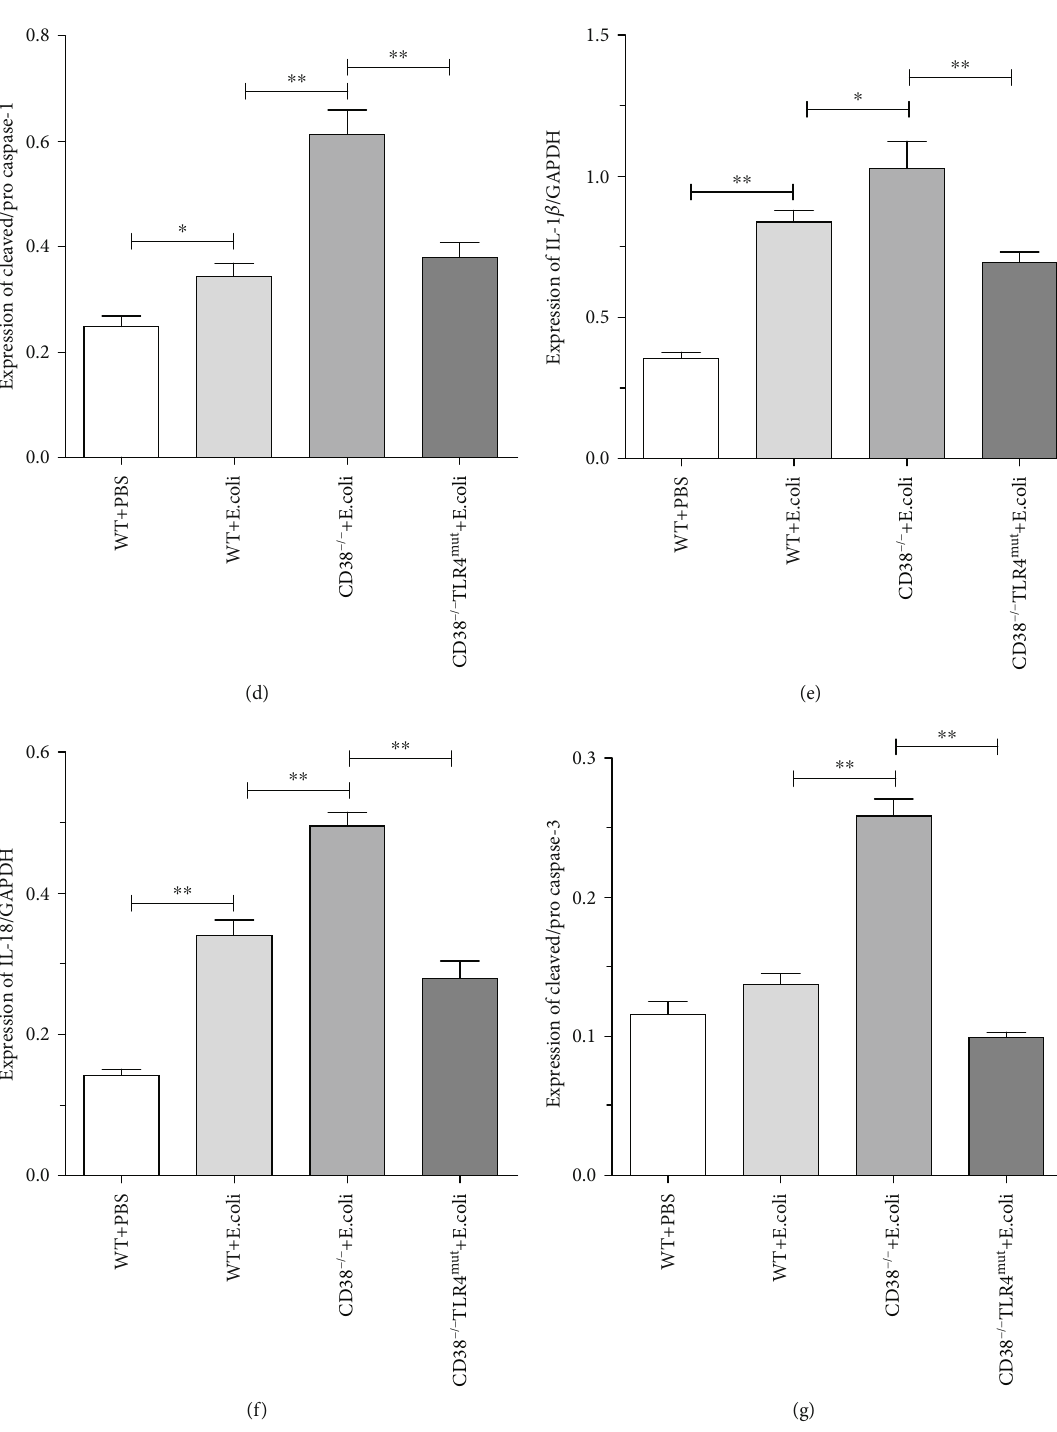
Figure 5: The expression levels of pyroptosis-related markers were detected by Western blot. The expressions of liver pyroptosis proteins in WT, CD38 -/- , and CD38 -/- TLR4 mut mice were detected at 3 hours after E. coli stimulation by Western blot. The expressions of NLRP3, ASC, procaspase-1, cleaved caspase-1, IL-1 β , IL-18, procaspase-3, and cleaved caspase-3 were measured (a). And relative levels of NLRP3 to GAPDH (b), ASC to GAPDH (c), cleaved to procaspase-1 (d), IL-1 β to GAPDH (e), IL-18 to GAPDH (f), and cleaved to procaspase-3 (g) were analyzed by ImageJ software. Data are presented as means ± standard deviation . Statistical signi fi cance was determined by one-way ANOVA ( n = 3 , ∗ p < 0 : 05 , ∗∗ p < 0 : 01